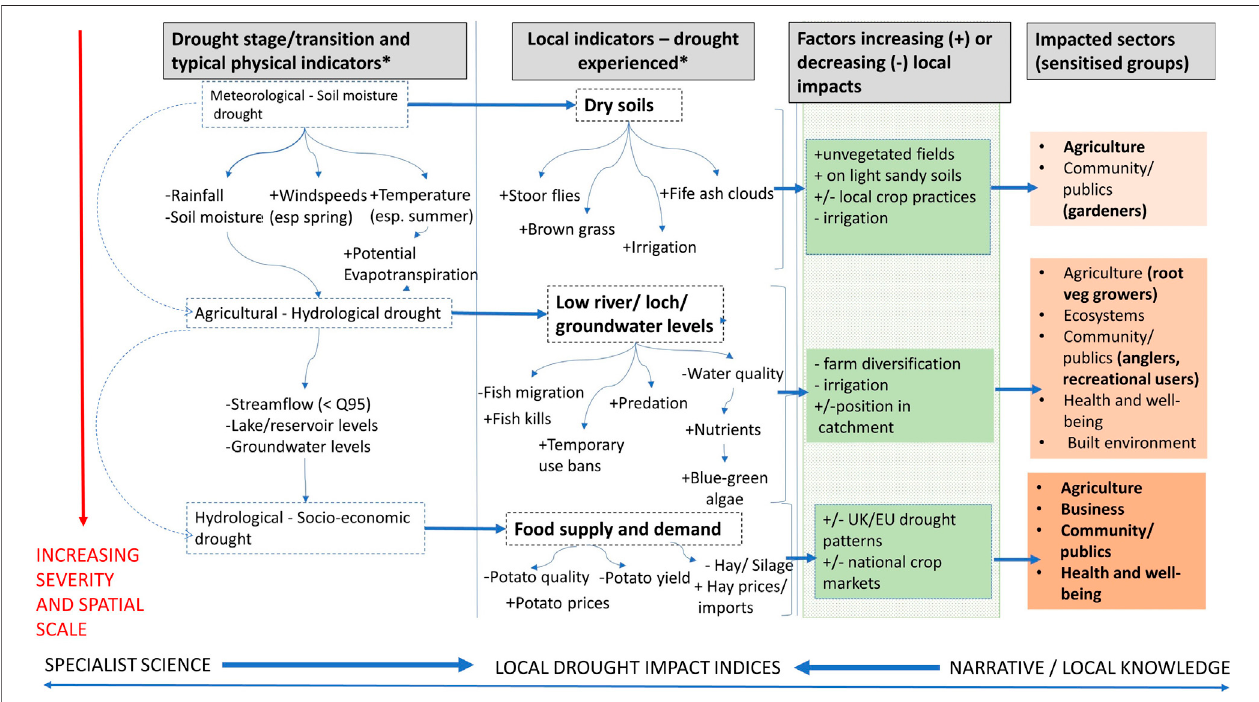
FIGURE 11 | Development of a framework for science-narrative drought “ threshold thinking. ”